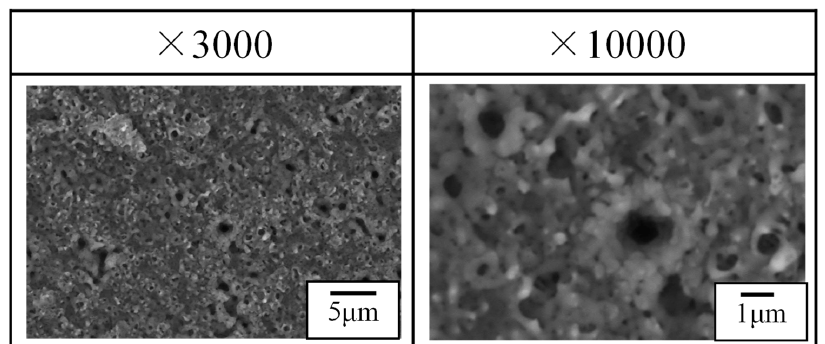
Figure 10. Discharge craters on the anode surface after the PEO process by ST operation.